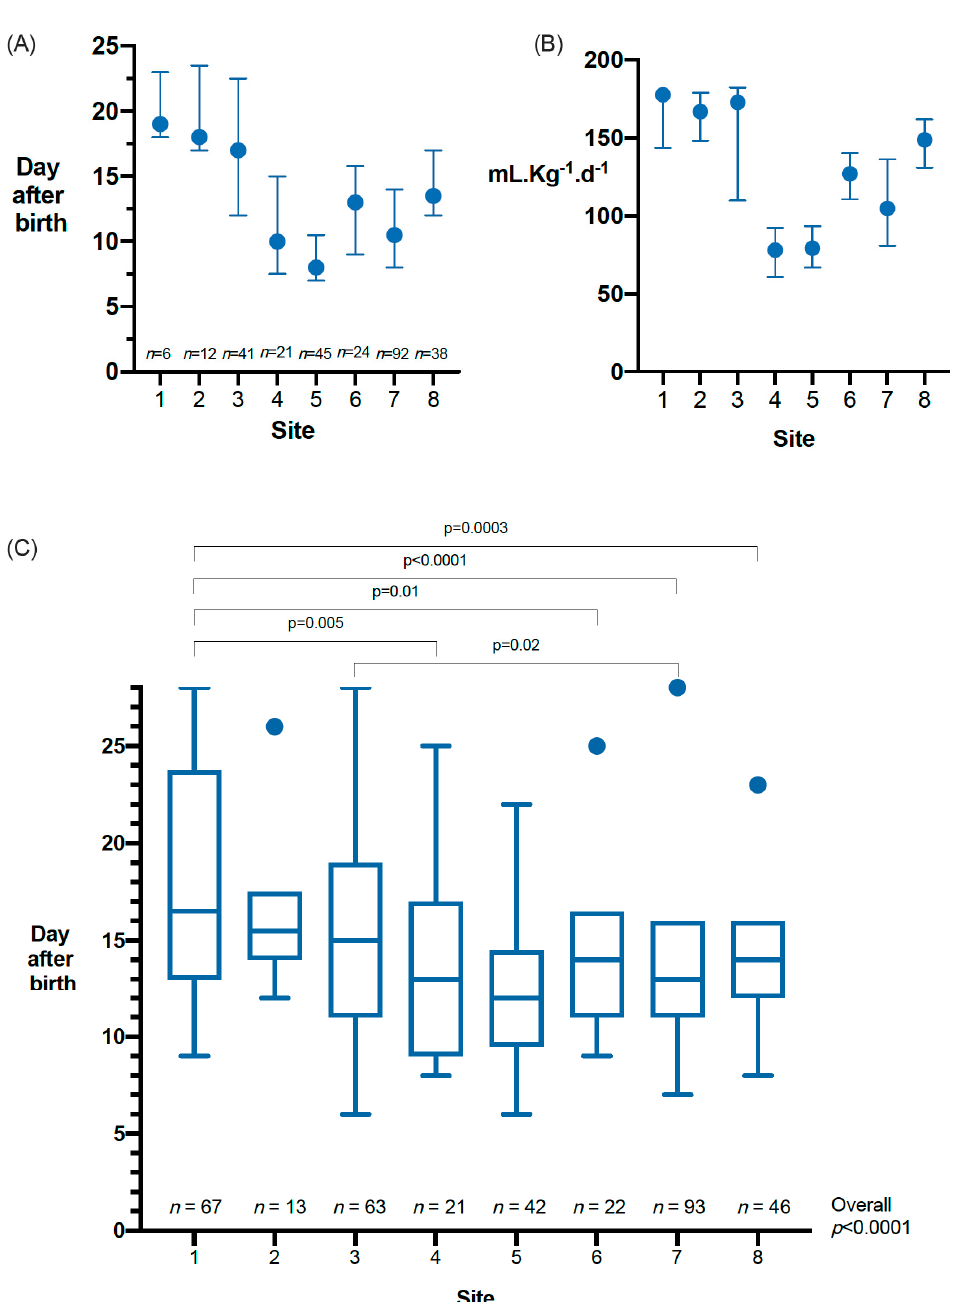
Figure 2. Enteral feeding and timing of breastmilk fortifier addition in participating sites. ( A ) Day after birth of the first fortified feed or preterm formula n = 279. ( B ) Feed volume in mL · Kg − 1 · d − 1 at the time of the first fortified feed or preterm formula n = 279. ( C ) Days to full enteral feeding (defined as the day when no further intravenous nutrition was given or 150 mL · Kg − 1 · d − 1 enteral feeds was reached). Bottom and the top of the box, the first and third quartiles; band inside the box, median; whiskers, 1.5 times the interquartile range, and circles, outliers. n = 367, 18 babies excluded ( C ) due to missing data on time from birth to full enteral feeds. From birth to 36 weeks’ CA, the median (IQR) change in z-score for weight was − 0.48 ( − 1.09, 0.05), for length − 1.16 ( − 1.86, − 0.43), and for head circumference − 0.82 ( − 1.51, − 0.19) (Figure 3).